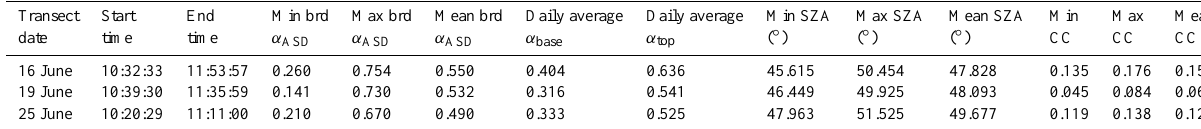
Table 1. Descriptive statistics for high-quality albedo transects. SZA and CC listed for Base Met Station only. “brd” is used to abbreviate broadband.